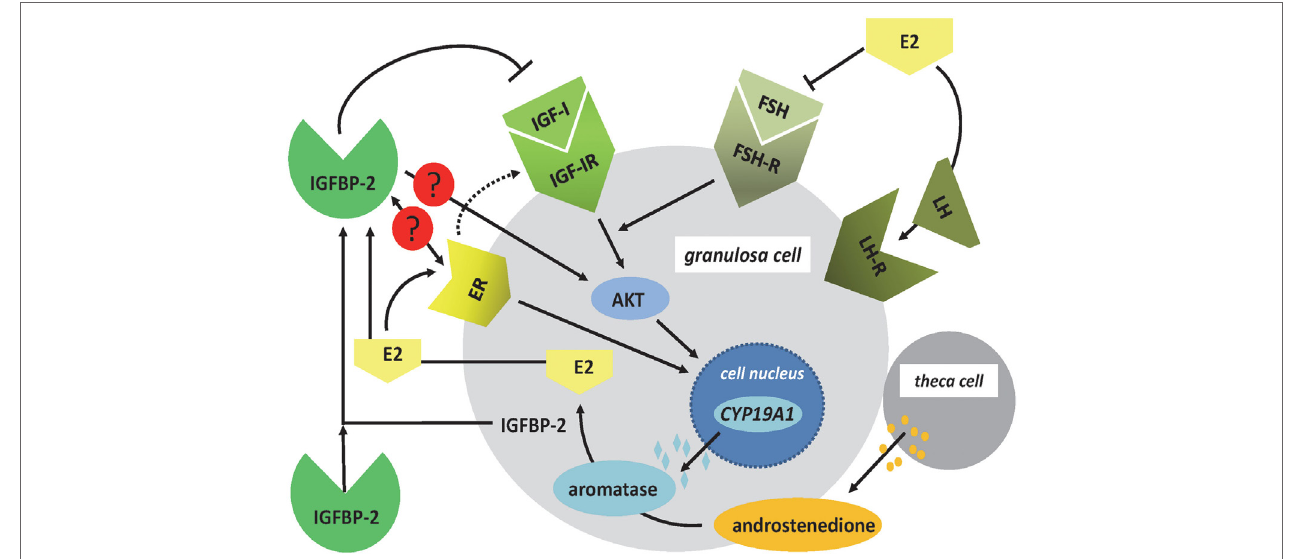
FiGURe 2 | Regulation of E2 synthesis in the ovarian follicle. In granulosa cells, nuclear expression of CYP19A1 is regulated by FSH- and ER signaling. The effects of FSH on the expression of CYP19A1 gene are mediated by IGF-IR signaling and AKT. ER signaling can also include the IGF-IR pathways. In addition, the ER has direct effects on CYP19A1 gene expression within the cell nucleus. Androstenedione, produced by theca cells, is used as a substrate for aromatase to produce E2. In granulosa cells, IGFBP-2 is regulated by E2, and IGFBP-2 has been shown to block FSH-dependent E2 production. Increased levels of E2 block the expression of FSH and induce the LH surge. Open questions in granulosa cells include the function of IGFBP-2 for ER- and IGF-independent effects of IGFBP-2 for E2 production (AKT, protein kinase B; CYP19A1 : aromatase; E2, 17beta-estradiol; ER, estrogen receptor; FSH, follicle-stimulating hormone; IGF-IR, IGF-I receptor; LH, luteinizing